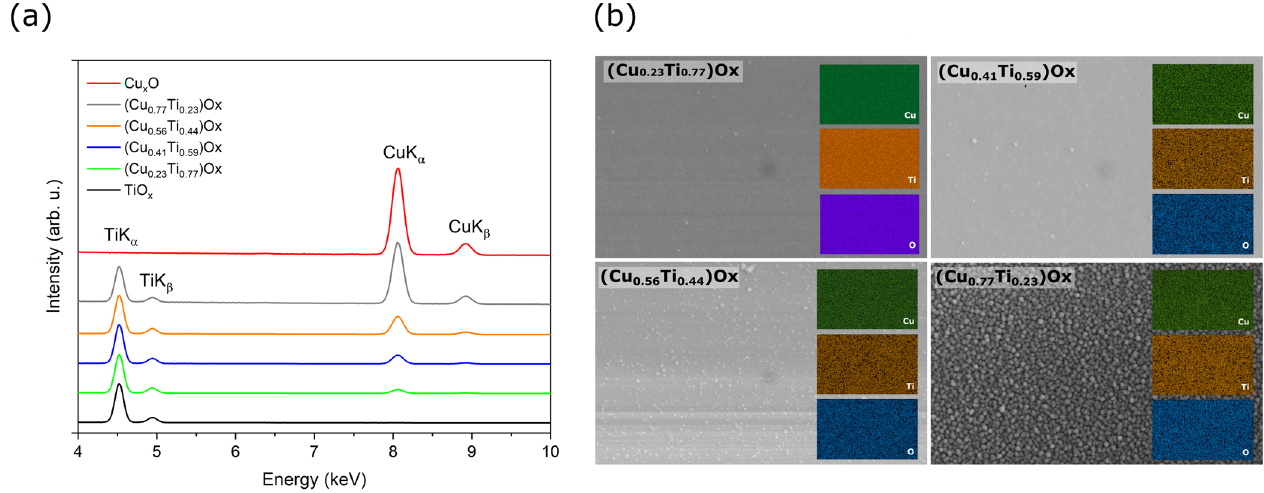
Figure 1. Results of X-ray microanalysis investigations for as-deposited copper and titanium oxide thin films: ( a ) EDS spectra and ( b ) maps of elemental distribution of mixed oxides.